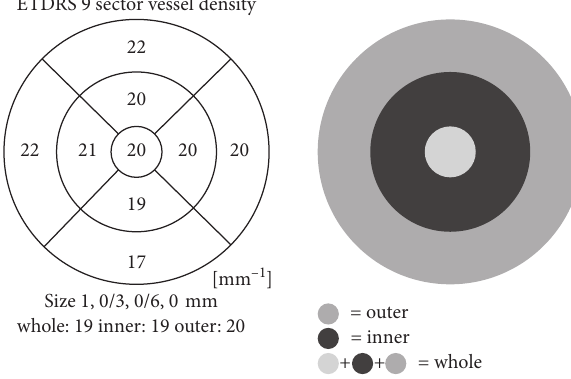
Figure 1: Sector vessel